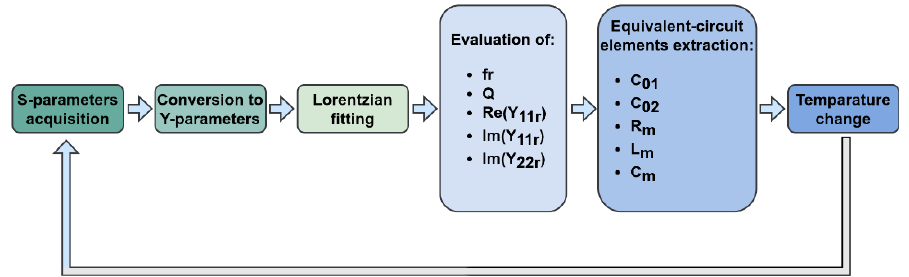
Figure 4. Diagram of the equivalent-circuit elements extraction